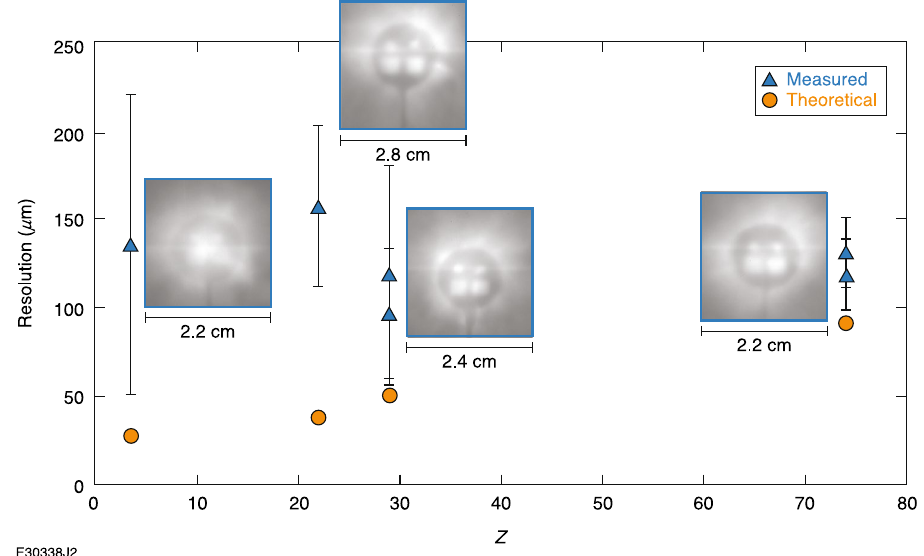
Figure 6. Resolution in the object plane versus atomic number ( Z ) of the target material for the projection configuration when the image plate was 8 cm from the location of the best laser focus. Theoretical predictions are calculated using Eq. (3). Each data point has the radiograph recorded on the image plate next to it.